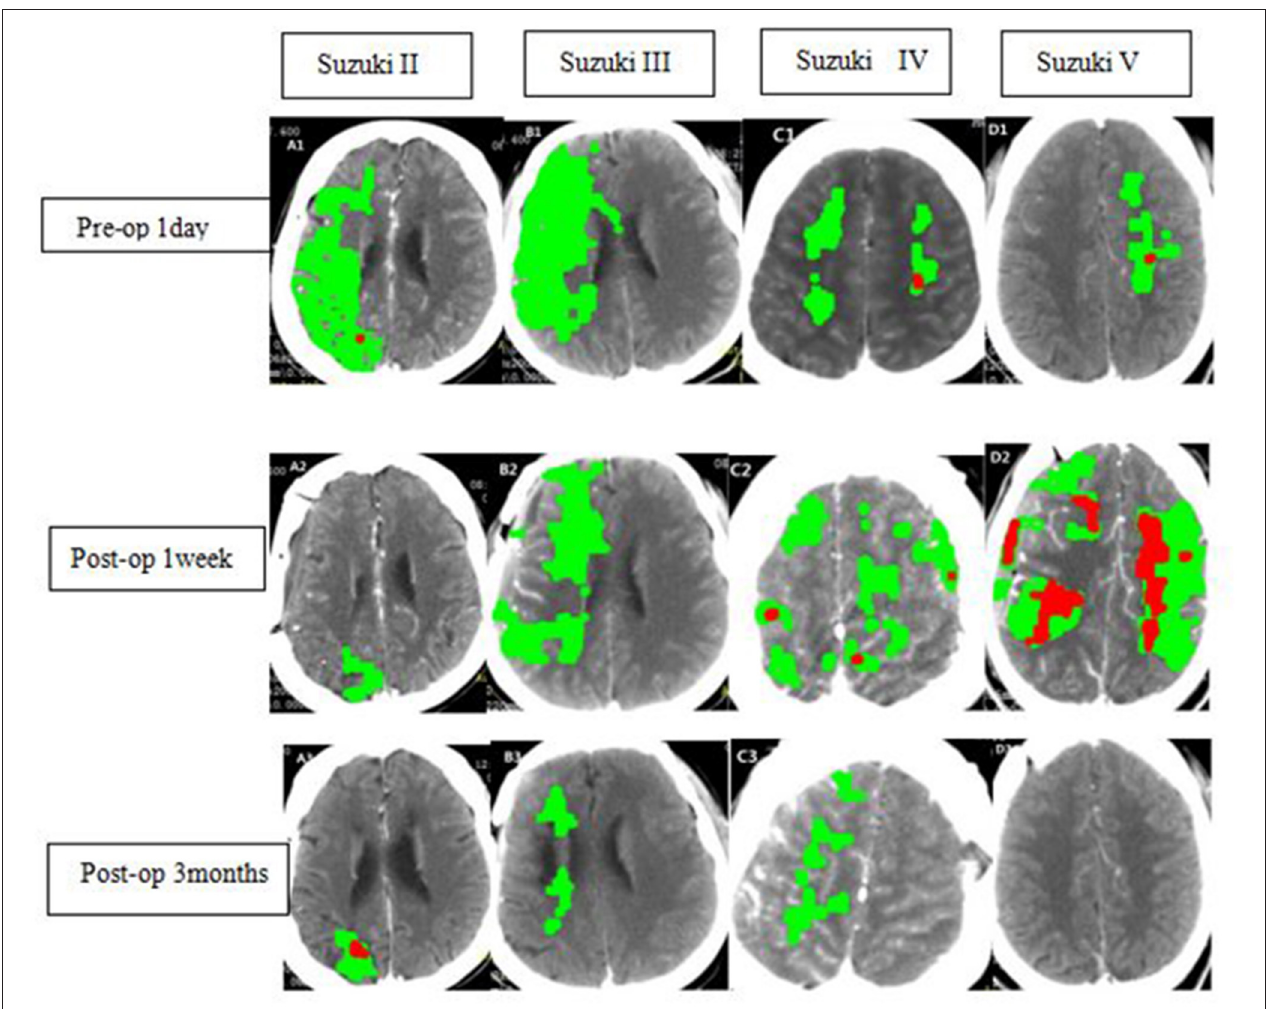
FIGURE 1 | Radiological findings in ischemic MMD patients of different Suzuki stages at different time points. WB-CTP indicating the volume of ischemic penumbra (delayed time > 3s, green) and infarct core (relative cerebral blood flow < 30%, red).A1-A3, B1-B3, C1-C3, D1-D3 showing WBC-CTP 1 day before bypass (Pre-op 1d), 1 week after bypass (Postop 1 week)and 3 months after bypass(Postop 3 months) of ischemic MMD patients at Suzuki stage II, III, IV, and V.